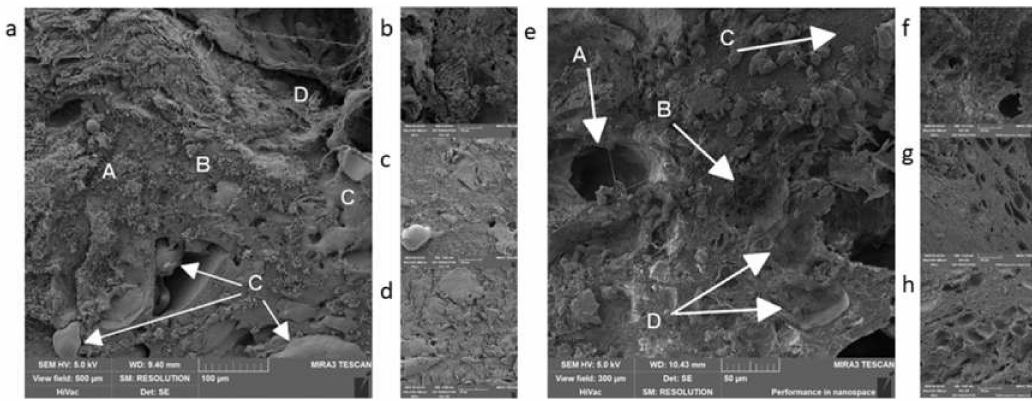
Figure 7. Long-life fermented meat products: ( a , b )—Dunajsk á ” sausage, procedure 1, A—artifacts, B—connection, C—fat, D—crosslinked protein; ( c , d )—“Poliˇcan”, procedure. 1; ( e , f )—“Poliˇcan”,